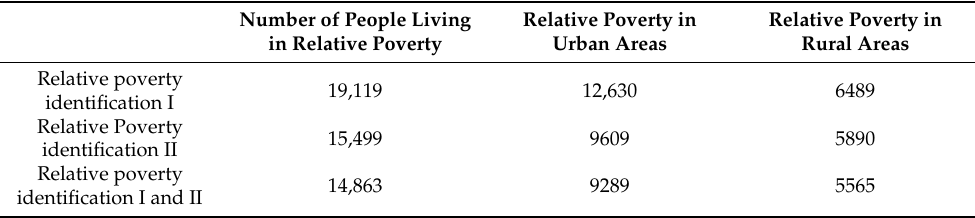
Table 4. Number of people living in relative poverty in urban and rural areas (person). Number of People Living Relative Poverty in in Relative Poverty Urban